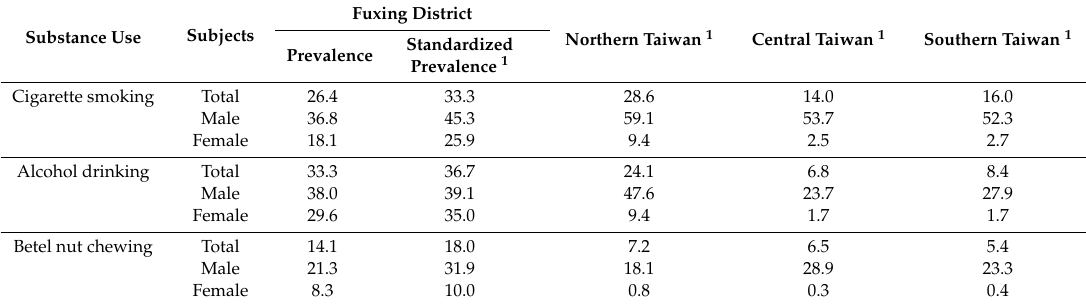
Table 2. Crude and standardized prevalence of substance usage compared with other parts of Taiwan. Substance